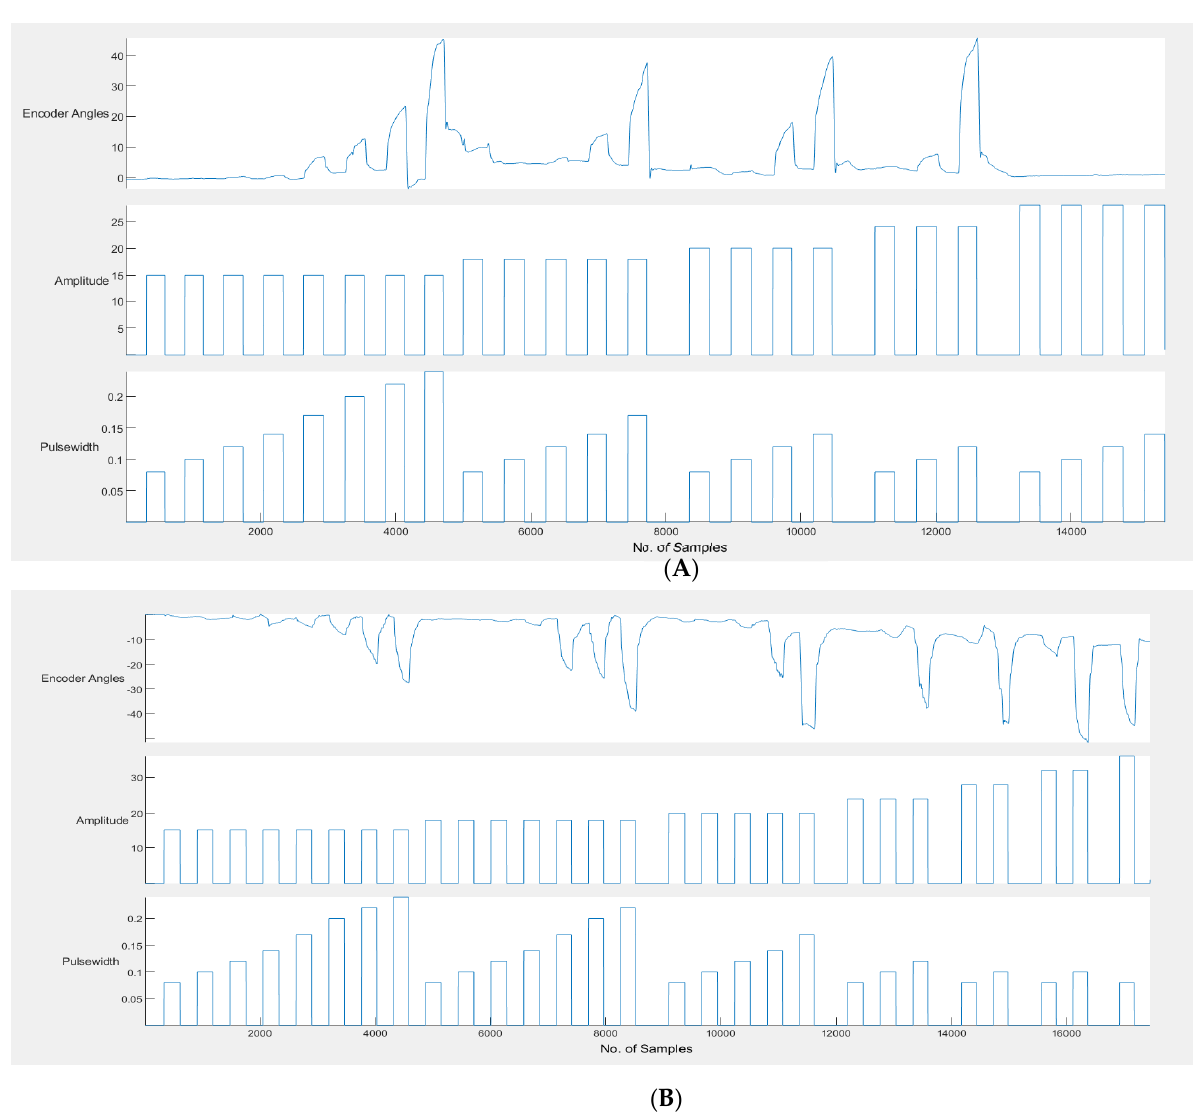
Figure 7. ( A ) Example calibration graph for left extension. ( B ) Example calibration graph for left flexion. The encoder angles obtained for each increase in amplitude and pulse width.